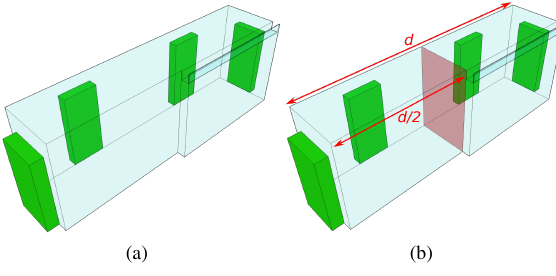
Figure 5. Subdivision mainly based on geometric criteria. (a) A corridor space. (b) Its subdivision in two subspaces based on its length